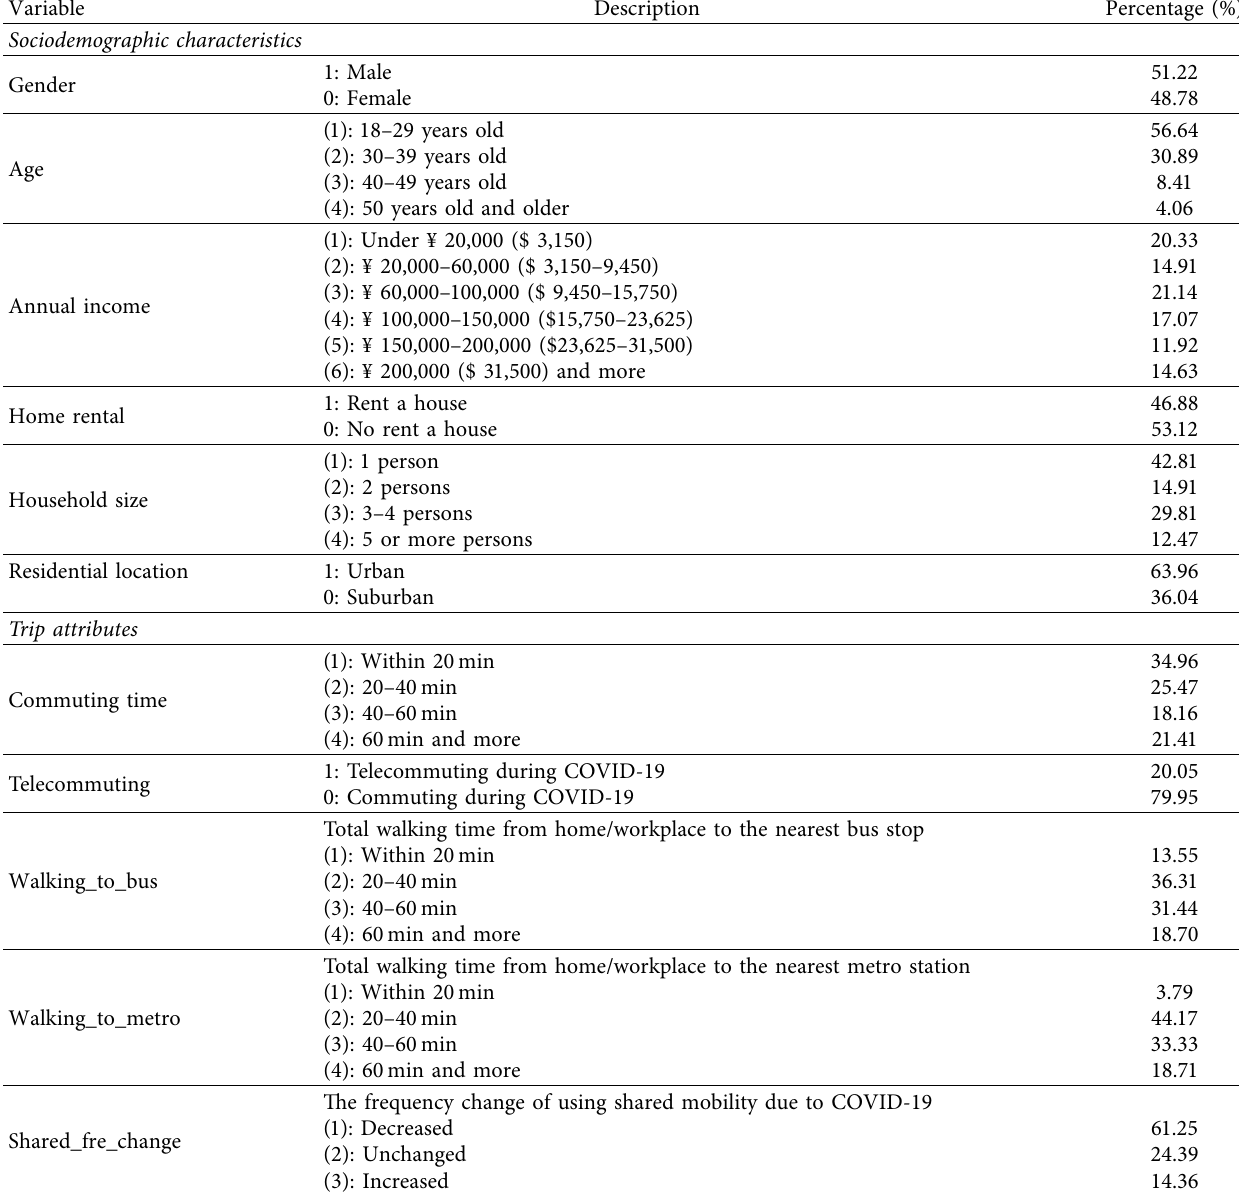
Table 3: Statistics of car-free